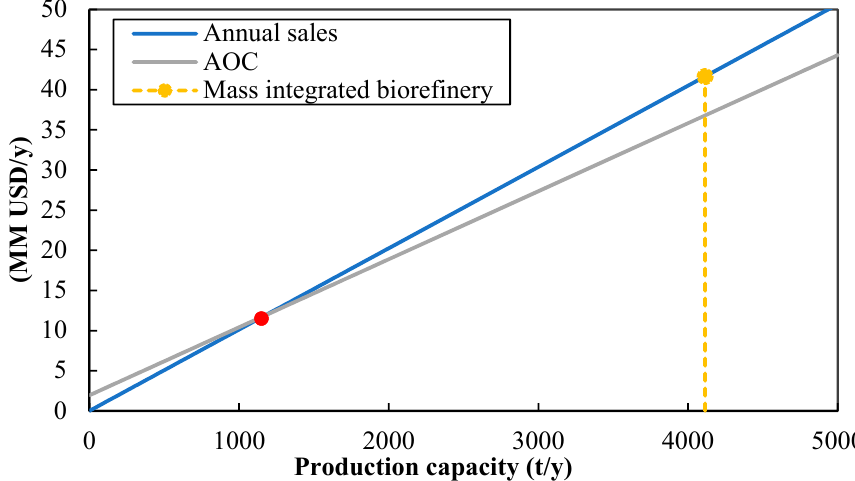
Figure 3. Break-even analysis for the mass integrated approach for a shrimp biorefinery.